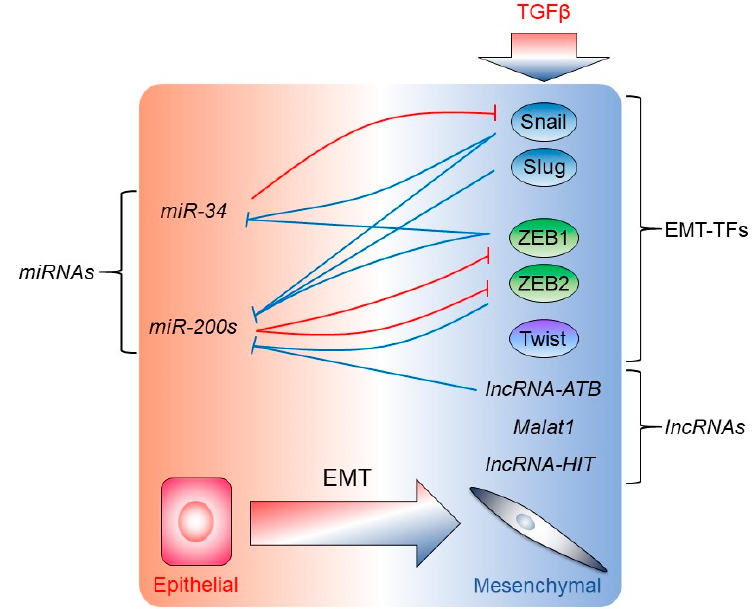
Figure 3. The non-coding RNAs regulate the EMT. Epithelial (left) and mesenchymal (right) genes are listed, the latter being transcriptionally induced by TGF β signaling (thick arrow). Thin T-bars indicate the negative regulation of EMT-TFs by miRNAs and inversely, the negative regulation of miRNA expression by the EMT-TFs or lncRNAs . Negative transcriptional regulation is shown with blue T-bars, whereas negative regulation of mRNA translation and stability by miRNAs is shown with red T-bars.